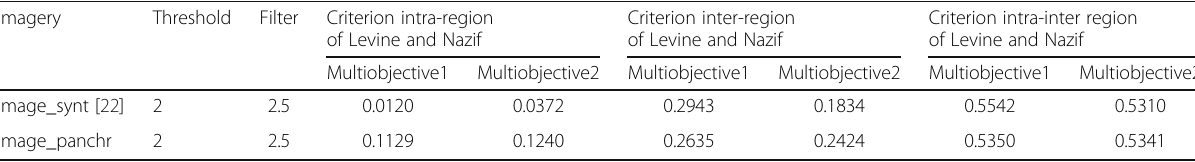
Table 2 Values of Levine and Nazif evaluation of criteria for various functions (MOBJ1 and MOBJ2) Imagery Threshold Filter Criterion intra-region Criterion inter-region of Levine and Nazif of Levine and